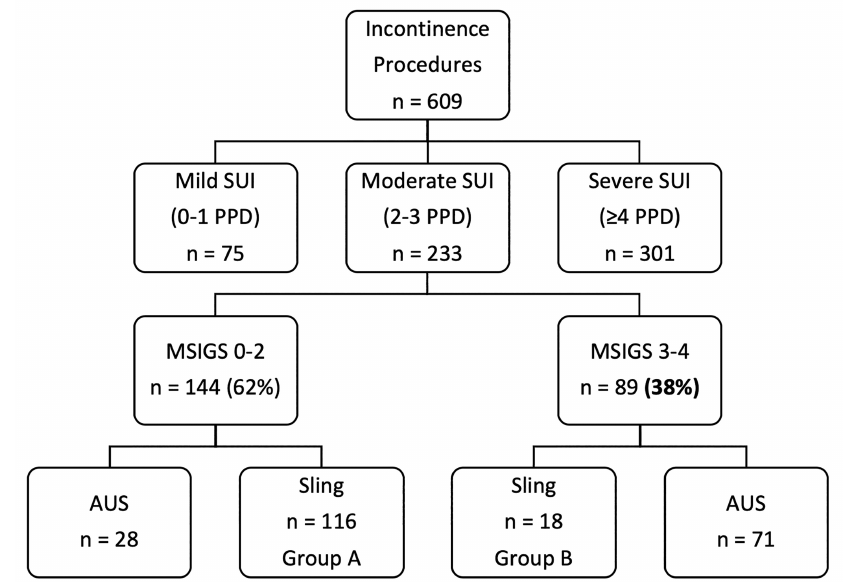
Figure 1 - Flow chart. Patients with moderate SUI were stratified into favorable and unfavorable, depending on Male Stress Incontinence Grading System (MSIGS)